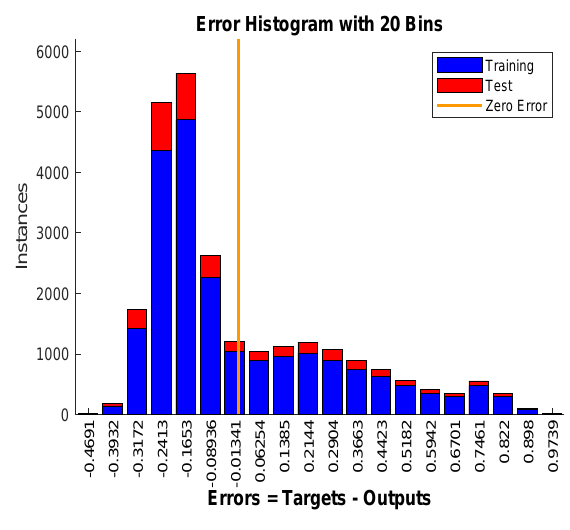
Figure 19. The error